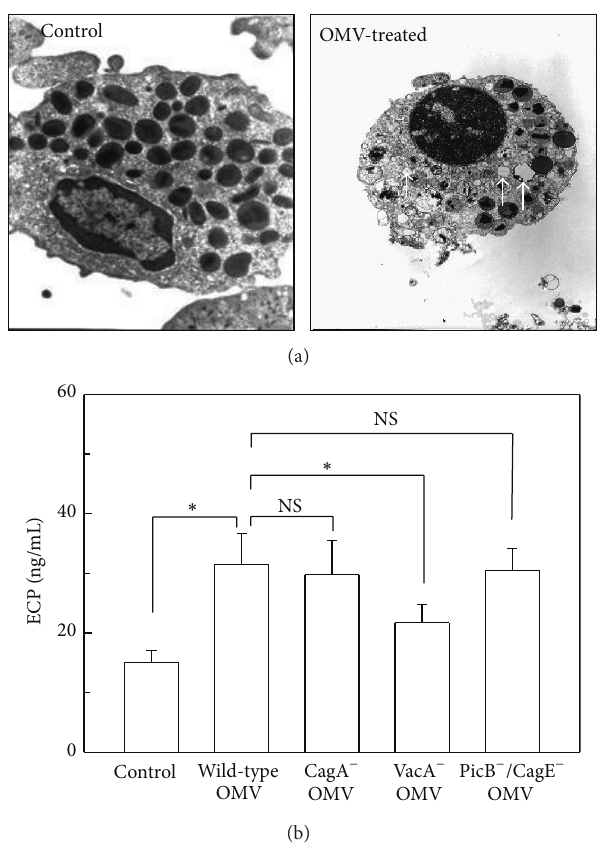
Figure 1: Degranulation of eosinophils stimulated with H. pylori OMVs. (a) Freshly isolated human eosinophils were stimulated with H. pylori OMVs (200 𝜇 g/mL) for 24 h. Cells were analyzed by TEM ( × 12,000). OMV-treated cells exhibited cytoplasmic degranulation (arrowhead). (b) Human eosinophils were stimulated with OMVs (200 𝜇 g/mL) obtained from wild-type H. pylori or the indicated isogenic mutants for 24 h. The concentrations of ECP in the culture supernatants were measured by ELISA (mean ± SEM, 𝑛 = 5 ). ∗ 𝑃 < 0.05 control; NS, statistically